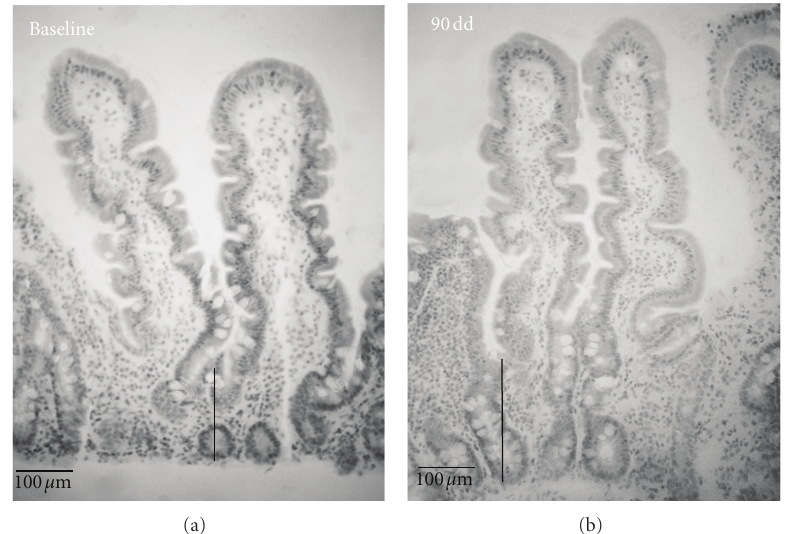
Figure 3: Histological appearance of intestinal mucosa from a CD subject at baseline (a) and following a 90-day (K-CH 3 )-transamidated gluten challenge (b). Lines indicate the crypt depths; original magnification: ×